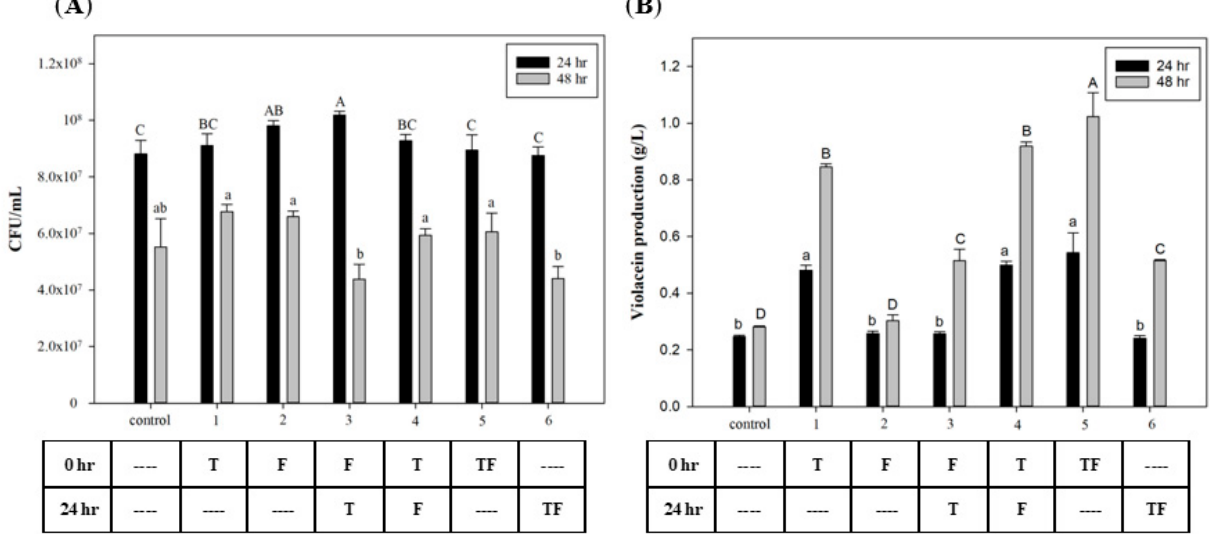
Figure 2. Effect of adding tryptophan and formic acid at different time points on ( A ) cell growth and ( B ) violacein production of C. violaceum . The different addition timing permutations of tryptophan and formic acid are presented in the table below the graph. T: 0.3 mg/mL tryptophan; F: 160 µg/mL formic acid. Each value is expressed as mean ± standard deviation ( n = 3). Different superscripts are significantly different ( p < 0.05).